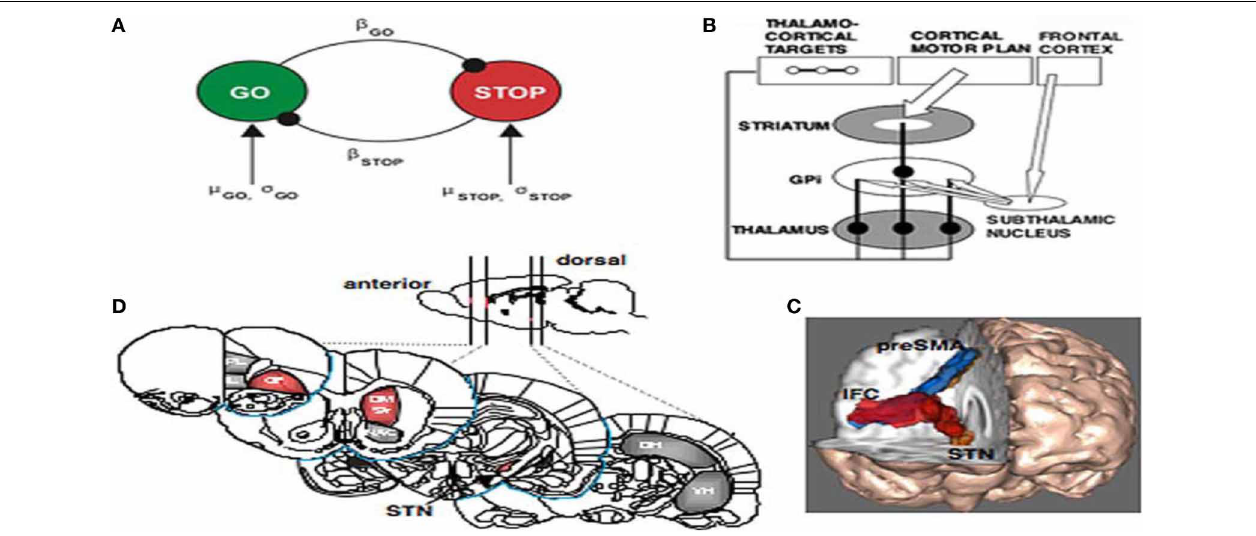
FIGURE 7 | (A) The interactive race model between Go and Stop processes. The parameters were estimated by fitting the model to thousands of behavioral trials from a monkey neurophysiology study. (B) Schematic of fronto-basal-ganglia circuitry for Going and Stopping. The Go process is generated by premotor cortex, which excites striatum and inhibits globus pallidus, removing inhibition from thalamus and exciting motor cortex (see text for details). The stopping process could be generated by IFC leading to activation of the subthalamic nucleus, increasing broad excitation of pallidum and inhibiting thalamocortical output, reducing activation in motor cortex. (C) Diffusion-weighted